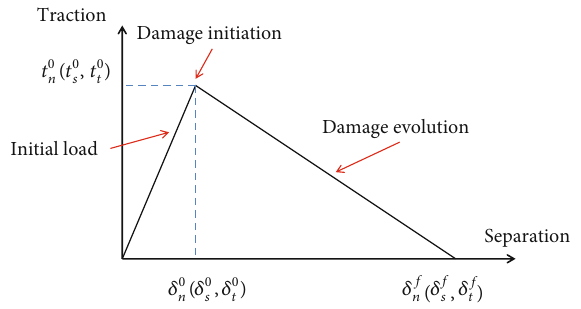
Figure 1: The quadratic nominal stress traction-separation law.